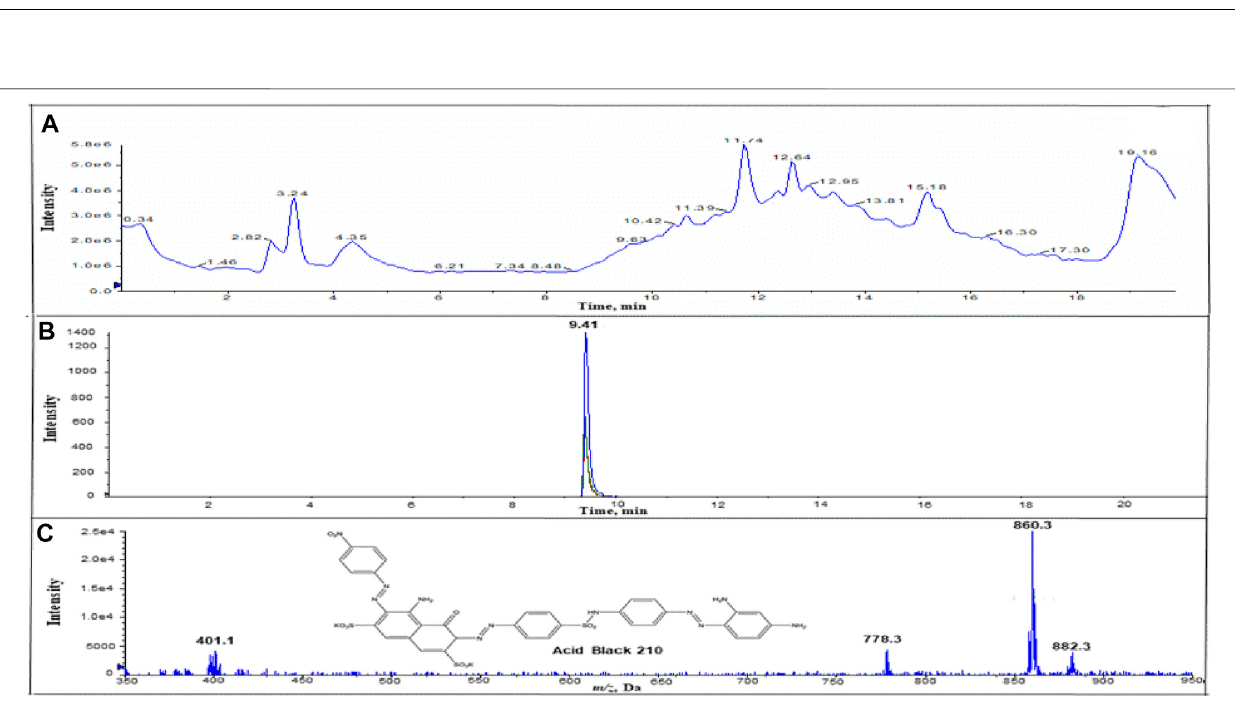
FIGURE 3 | (A) UV-Vis absorption spectra for chlorination of50 mg L − 1 of AB210 solution submitted to chlorination from 0 to 300 s. Time of exposition to chlorine gas: black line = 0 s and green line = 300 s. Spectra recorded each 25 s from 0 to 300 s of chlorination. (B) Discoloration of the AB210 at 612 nm in relation to the reaction time with active